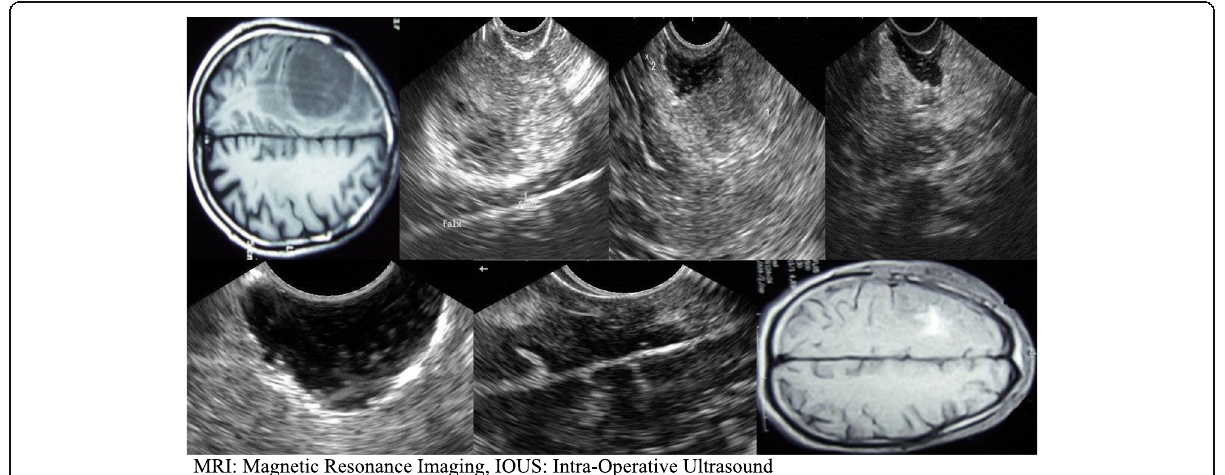
Fig. 7 Gross total resection of glioblastoma; preoperative and postoperative MRI T1 with contrast and staged resection IOUS images